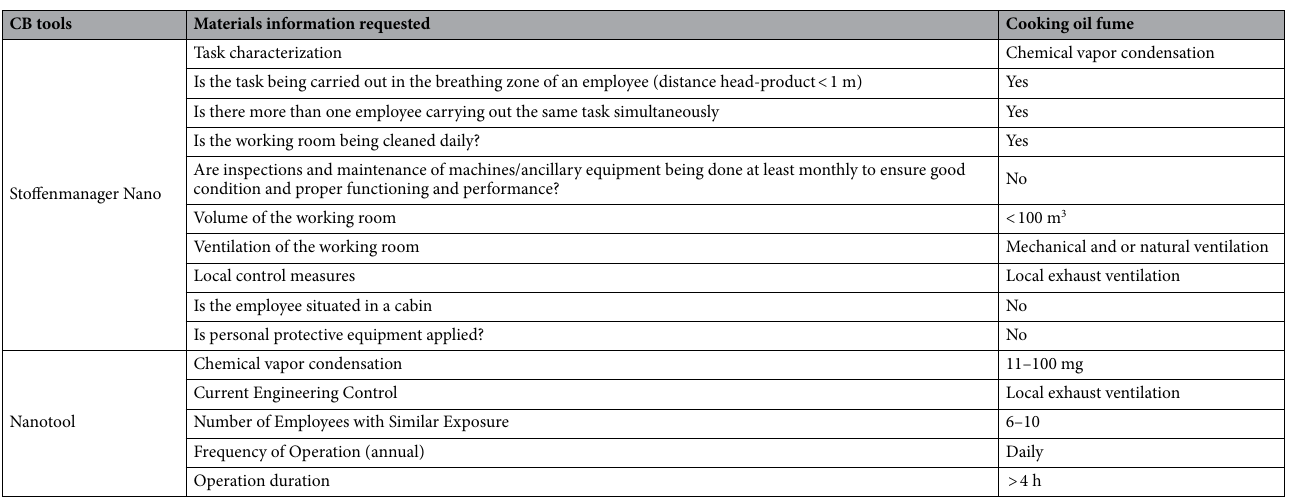
Table 3. Exposure scenario data input for the particles generated from